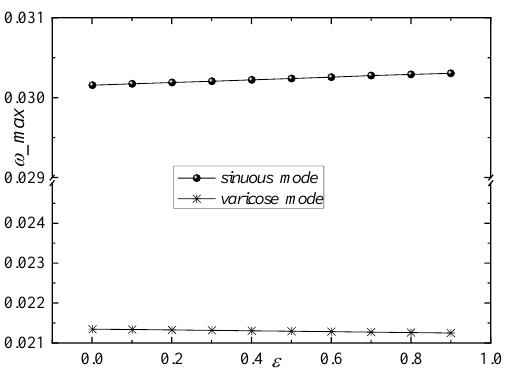
Figure 5. Effects of D on sheet instability for ( a ) sinuous mode and ( b ) varicose mode.